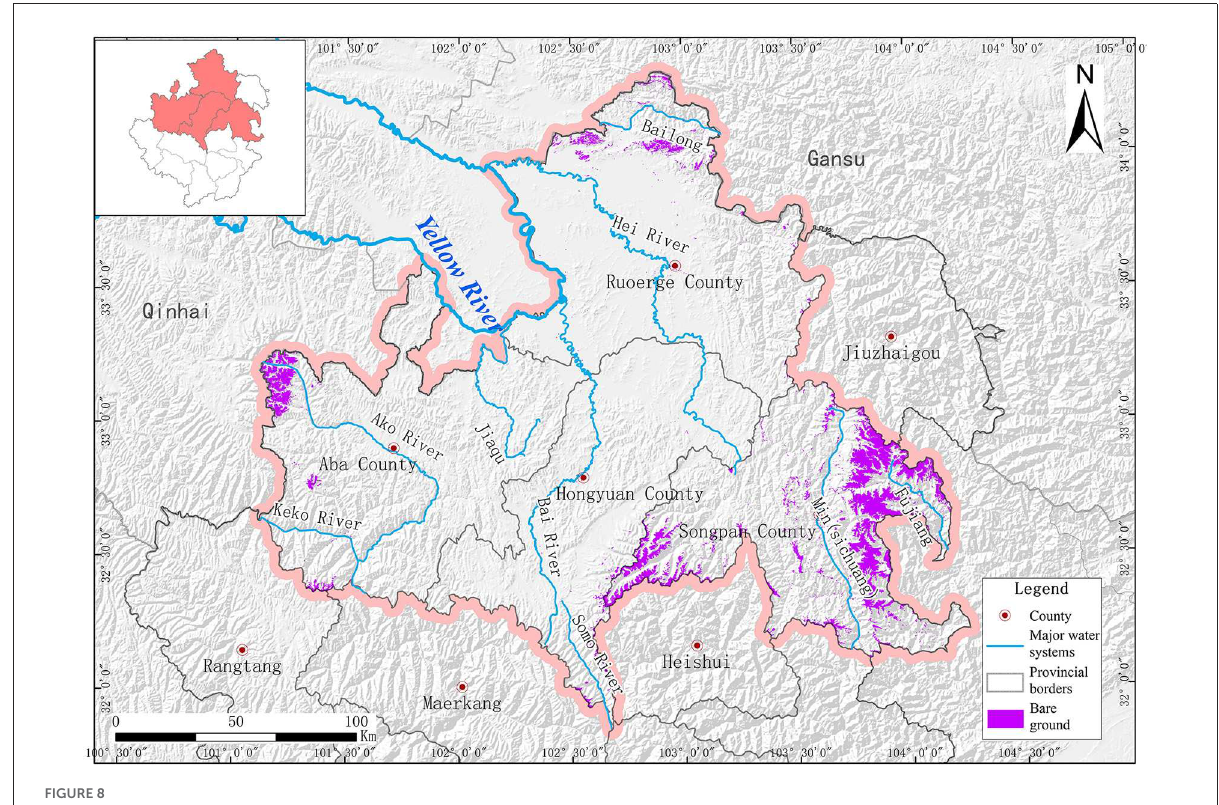
FIGURE8 Bare land ecosystem distribution in the study